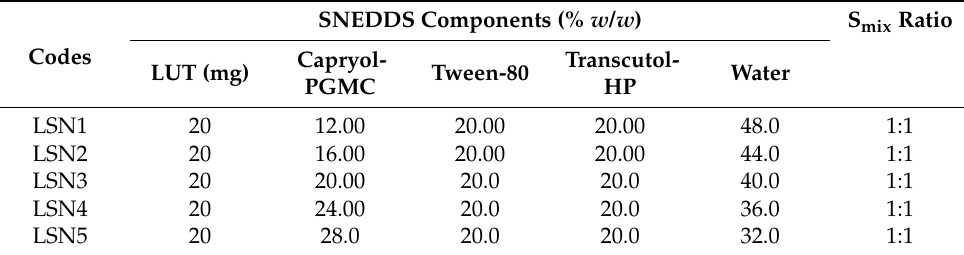
Table 2. Composition of self-nanoemulsifying drug delivery system (SNEDDS) prepared using Capryol-PGMC, Tween-80, Transcutol-HP, and deionized water.